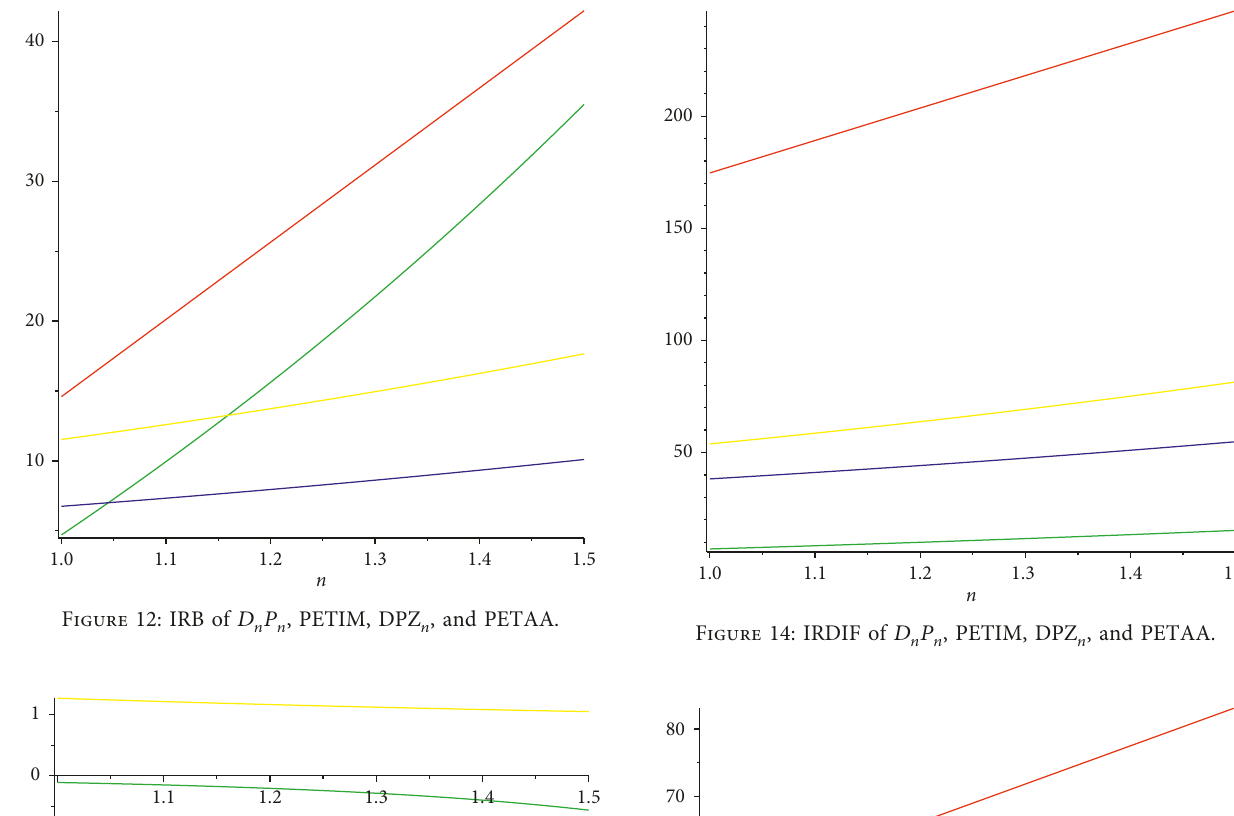
P n n , PETIM, DPZ n , and PETAA.